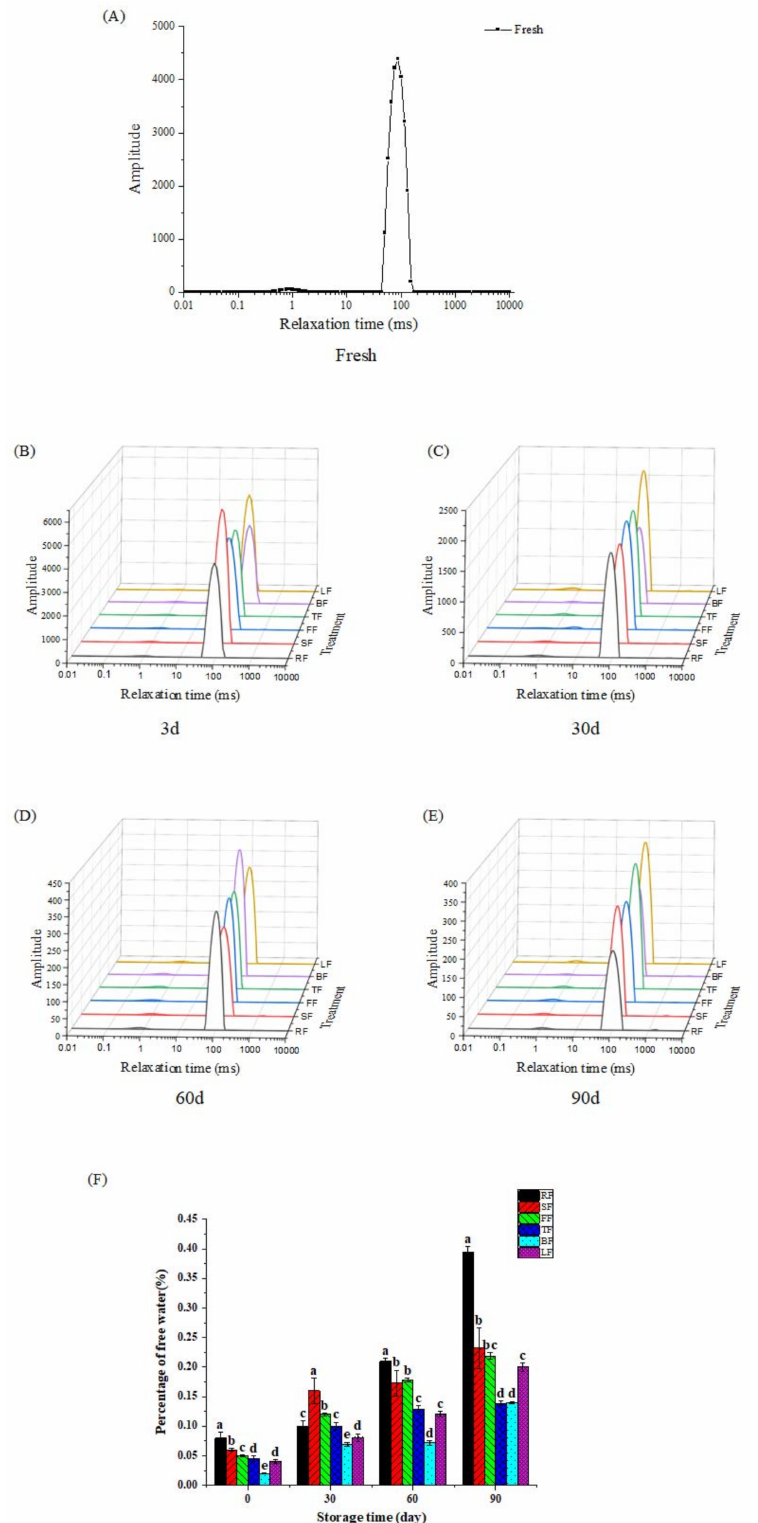
Figure 3. LF-NMR T 2 relaxation time distribution curves for cuttlefish with different treatment conditions ( A – E represent the samples stored for fresh, 3 d, 30 d, 60 d, 90 d, respectively). Change in percentage of free of cuttlefish during storage at − 18 ◦ C by different freezing methods ( F ). The letters “a–e” indicate significant differences ( p < 0.05). Error bars show standard